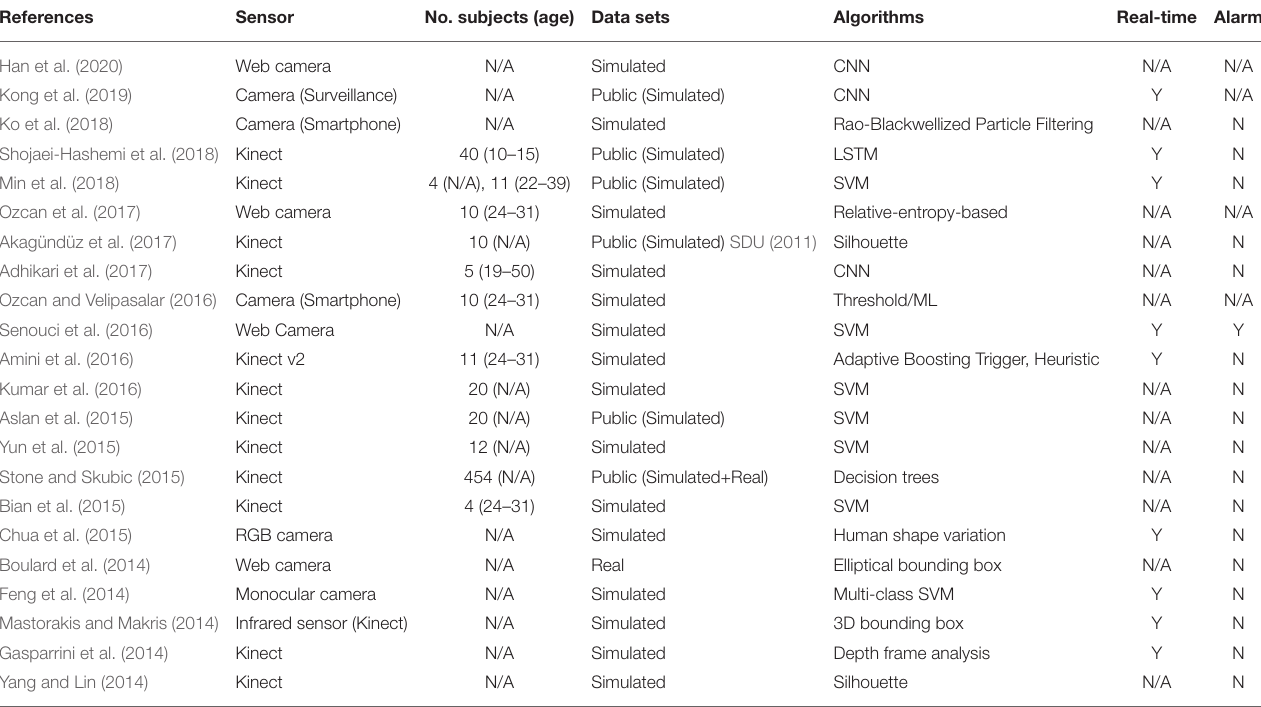
TABLE 4 | Fall detection using individual vision-based devices from 2014 to